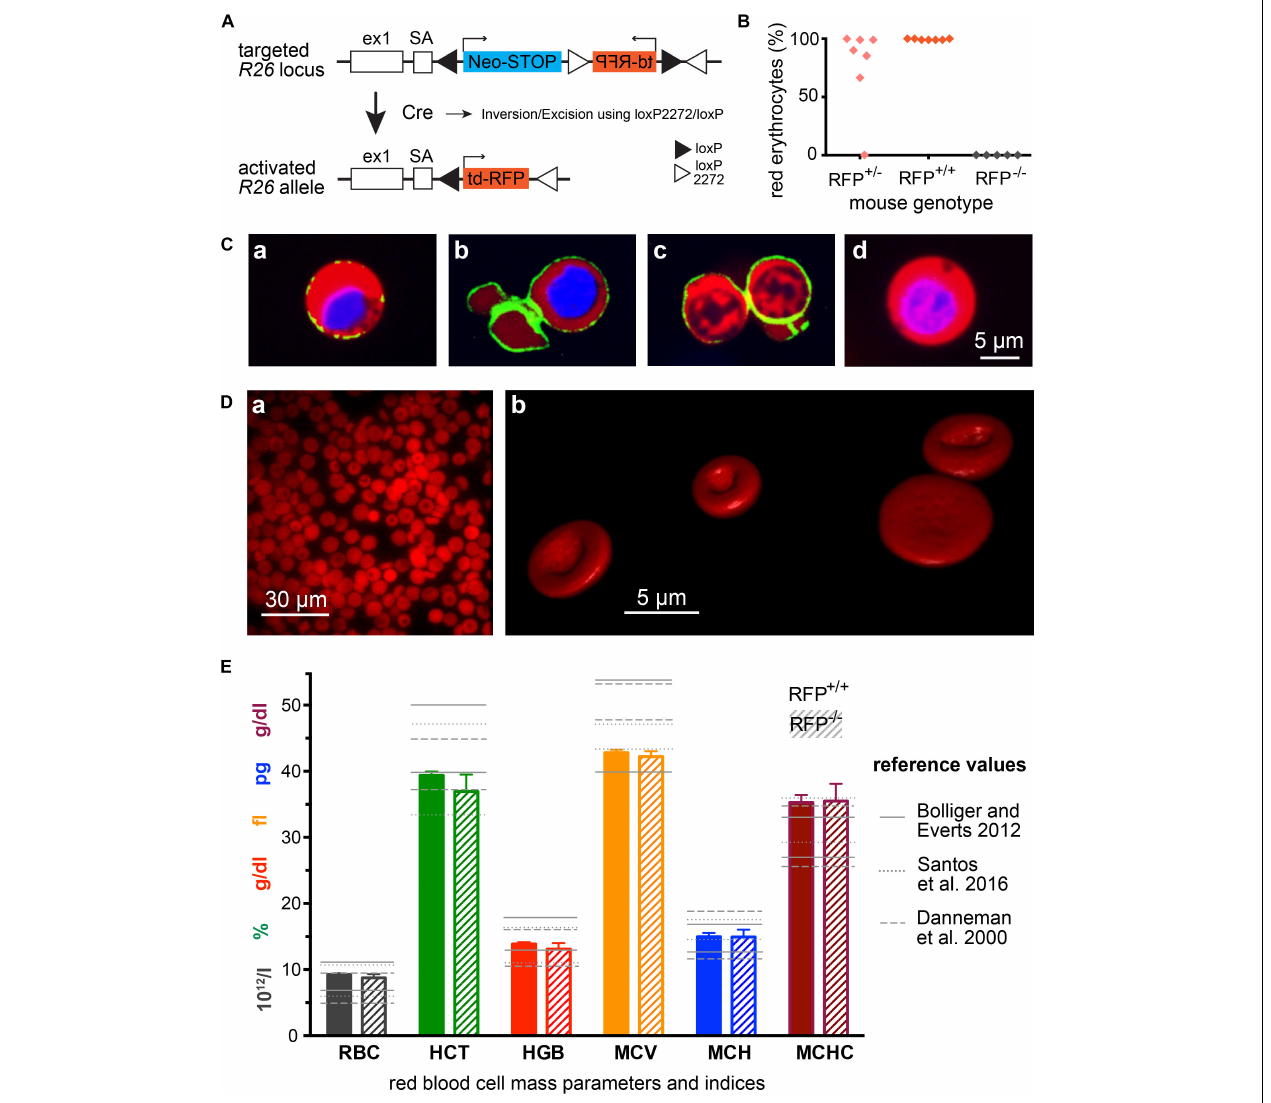
FIGURE 1 | Mice with RFP erythrocytes. (A) Genetic strategy to generate R26-tdRFP-CMV-Cre mice. Mice expressing Cre recombinase under control of the cytomegalovirus (CMV) promoter were bred to R26-tdRFP mice carrying a loxP -flanked tdRFP gene in the ROSA26 locus. R26-tdRFP-CMV-Cre mice ubiquitously express tdRFP controlled by the ROSA26 promoter. (B) Percentage of red fluorescent erythrocytes in RFP + / + (homozygous), RFP + / − (heterozygous) and RFP − / − (negative) mice. Each point represents an individual mouse. (C) Confocal images of cells from the bone marrow of R26-tdRFP-CMV-Cre mice. Beside the RFP fluorescence, the nuclei were stained with Hoechst dye (depicted in blue). Additionally a Ter119-FITC antibody was used to visualize the erythropoietic cells, (Ca) proerythroblast, (Cb) erythroblast, and (Cc) reticulocyte. For comparison we display a non-erythropoietic cell, and (Cd) from the bone marrow. (D) Images of RFP erythrocytes, (Da) epi-fluorescence microscopy of a population of erythrocytes, and (Db) 3D-rendered individual erythrocytes out of a z-stack of confocal images. (E) Erythrocyte mass parameters and indices. Displayed are the parameters erythrocyte count (RBC), haematocrit (HCT), haemoglobin (HGB), mean cellular volume (MCV), mean cellular haemoglobin (MCH), and mean cellular haemoglobin concentration (MCHC). The columns depict mean values and error bars represent the standard deviation out of 5 RFP + / + and 5 RFP − / − mice. The reference values are taken from Danneman et al. (2000), Bollinger and Everds (2012), and Santos et al.